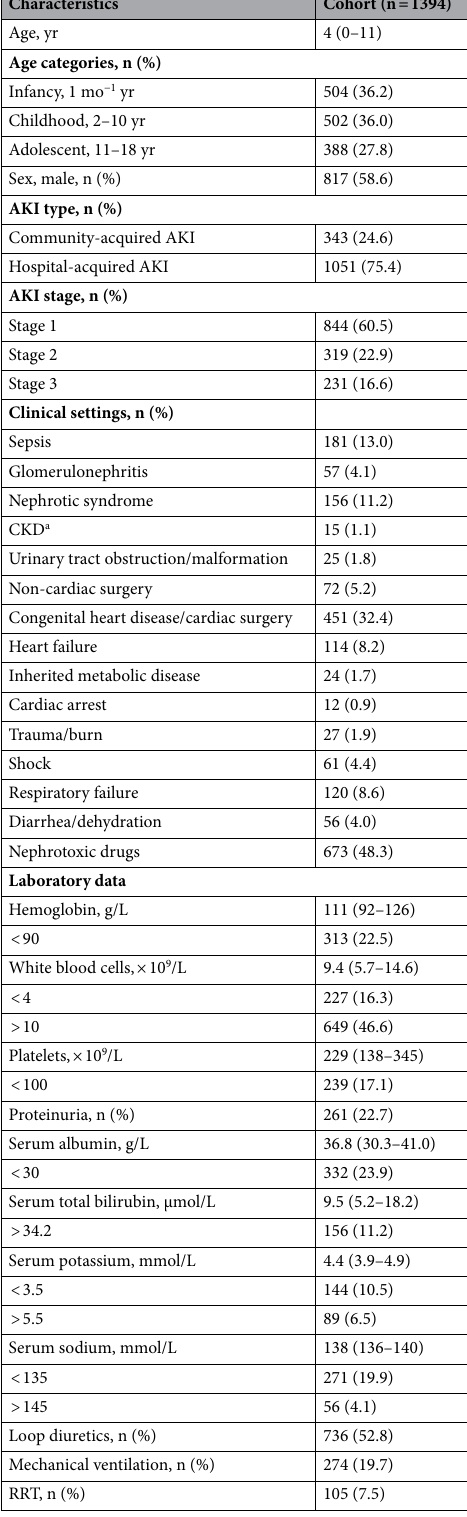
Table 1. Baseline characteristics of the study cohort. AKI acute kidney injury, CKD chronic kidney disease, RRT renal replacement therapy. Continuous variables are presented as median (interquartile range) and categorical variables are presented as n (%). Missing data: proteinuria (n = 245, 17.6%), serum albumin (n = 4, 0.3%), serum total bilirubin (n = 7, 0.5%), serum potassium (n = 29, 2.1%) and serum sodium (n = 29,